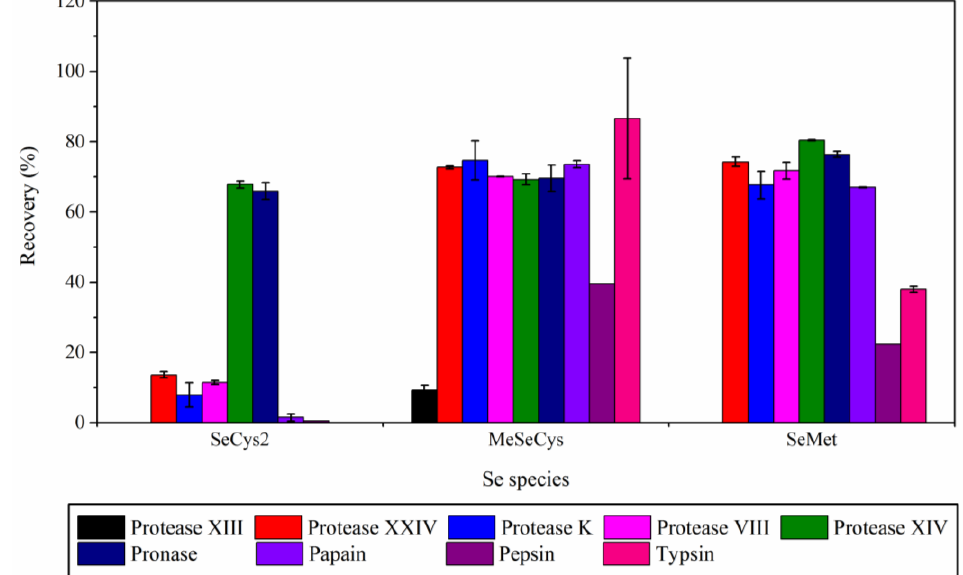
Figure 2. Spike recoveries of three Se species with different